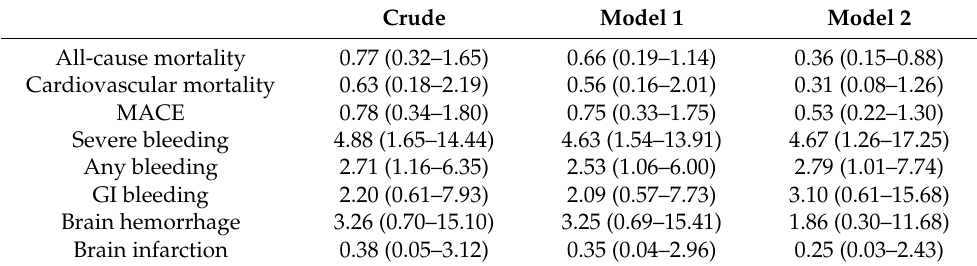
Table 2. Comparison of any anticoagulation and no anticoagulation.